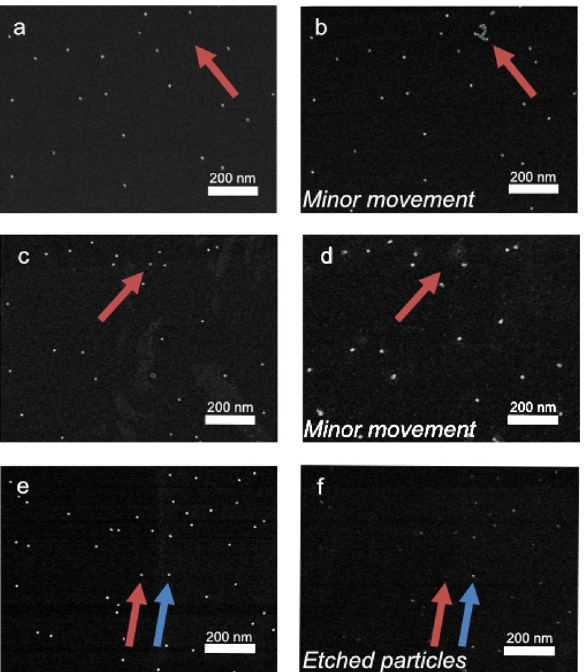
Figure 3. Representative IL - SEM images of AuNP/Si supports ( a ) before and ( b ) after treatment in room temperature H 2 O, ( c ) before and ( d ) after treatment in 95 °C H 2 O and ( e ) before and ( f ) after treatment in room temperature acetonitrile. The arrows mark examples of changes in the images before and after exposure to the solvent. The presence of additional nanoparticles in ( b ) and the absence of a few nanoparticles in ( d ) indicate minor movement of the nanoparticles. The decreased size of the particles in ( f ) compared to in ( e ) indicates that the nanoparticle has been